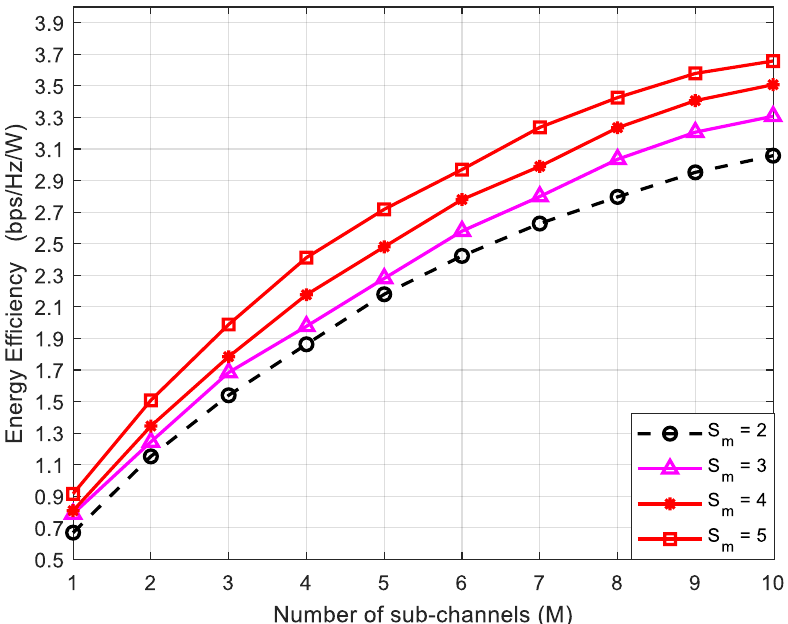
Figure 7. Energy efficiency against the number of sub-channels in the network for different IIoT devices per sub-channel.